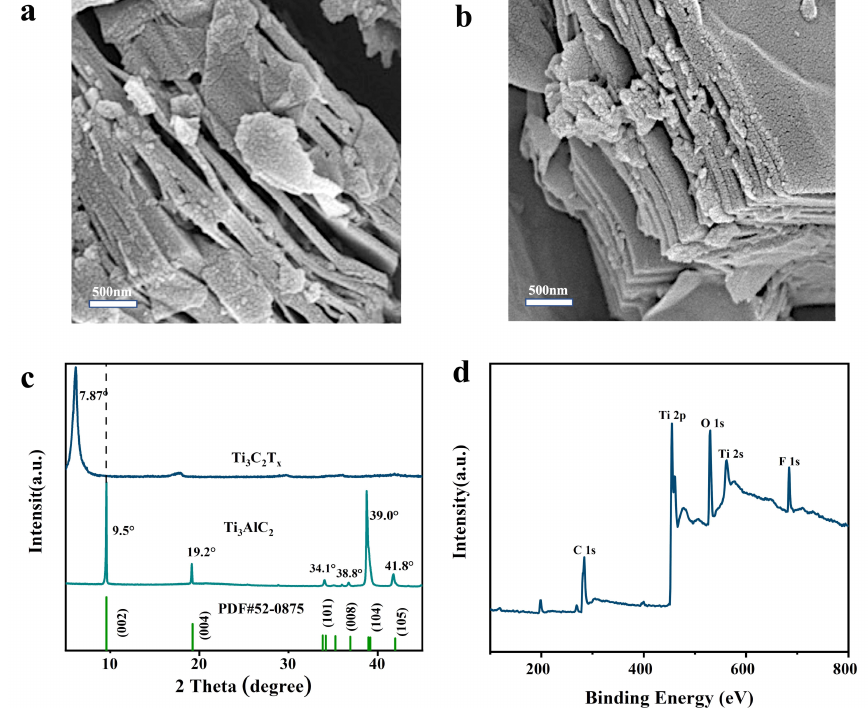
Figure 2. ( a , b ) SEM image of MXene material; ( c ) XRD spectra of Ti 3 AlC 2 and Ti 3 C 2 T X nanosheets; ( d ) XPS spectra of Ti 3 C 2 T X